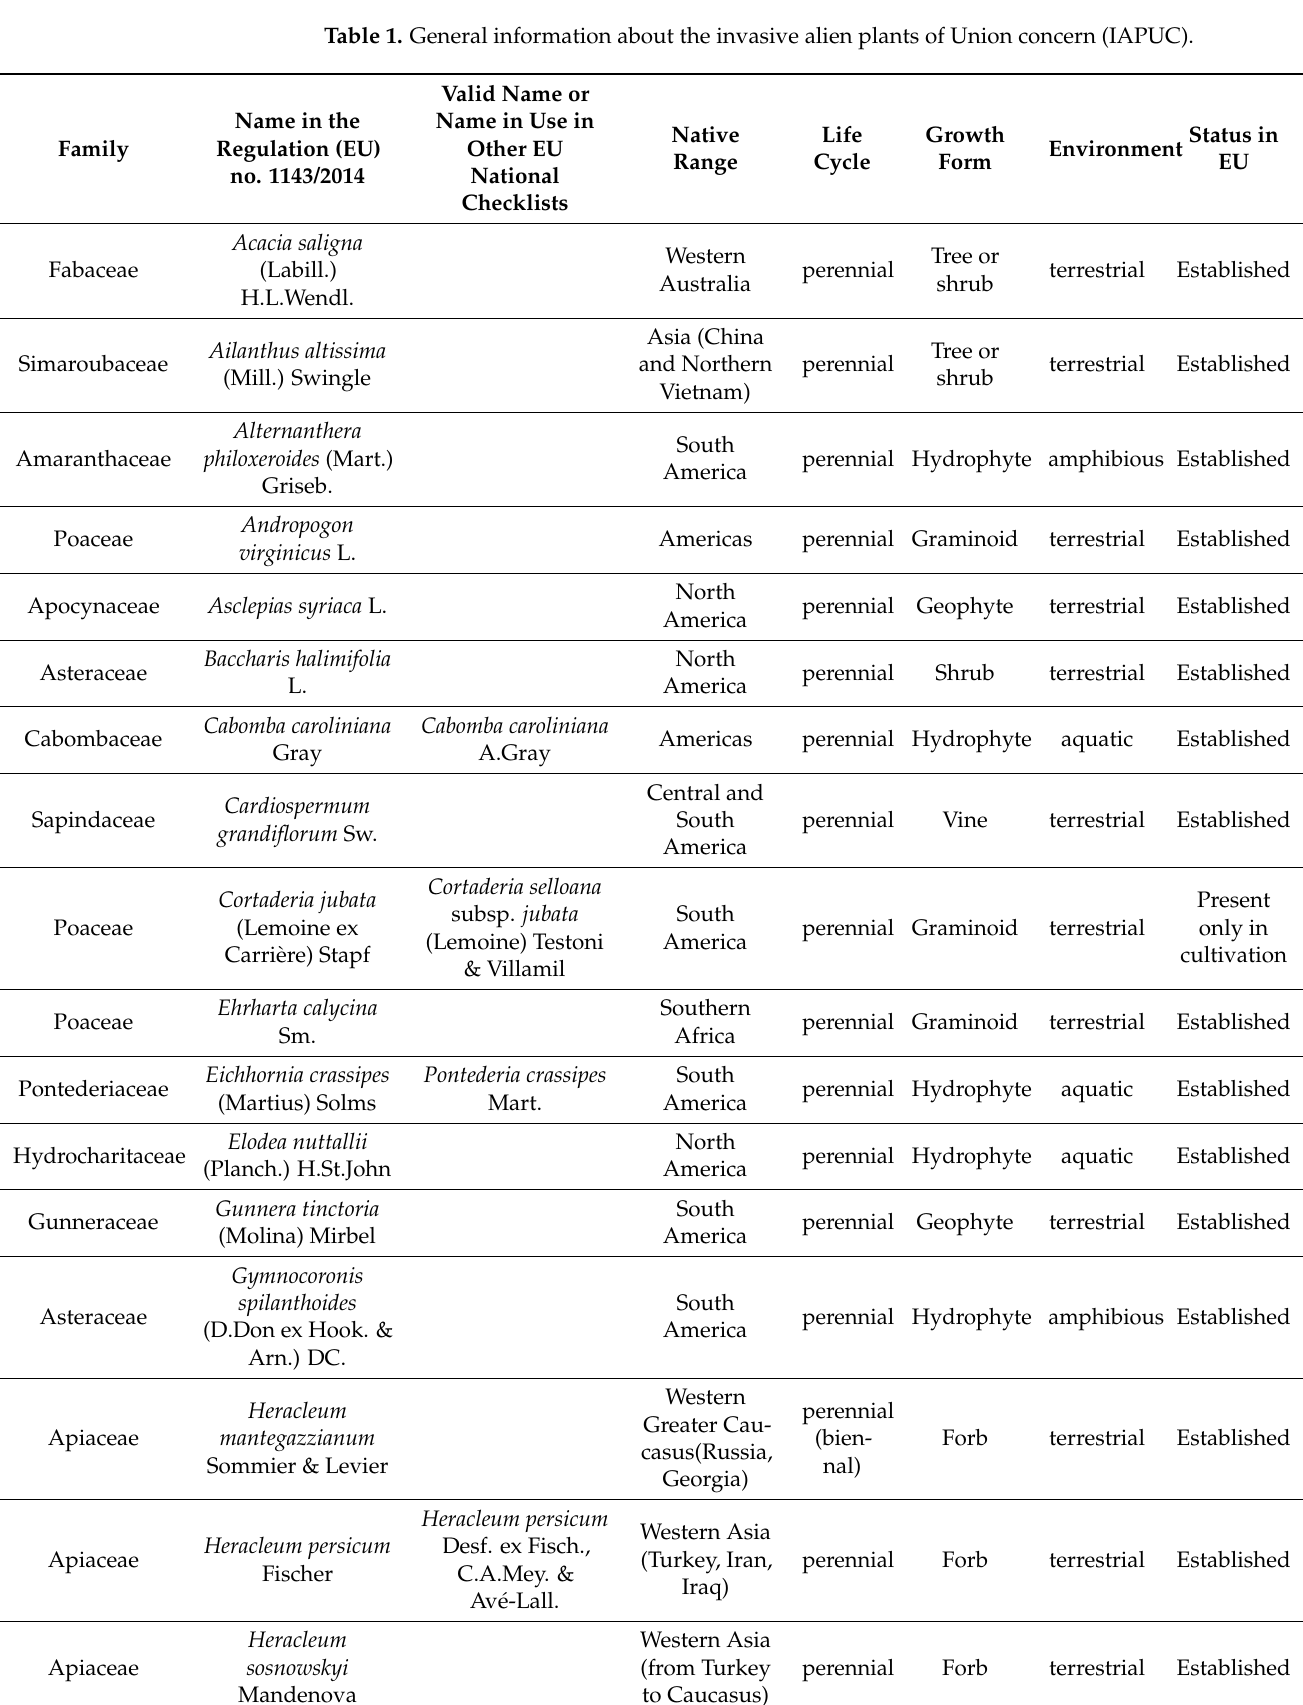
Table 1. General information about the invasive alien plants of Union concern